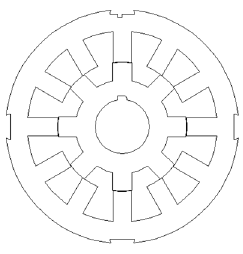
Figure 7. Stator and rotor cogging structure of SRM.